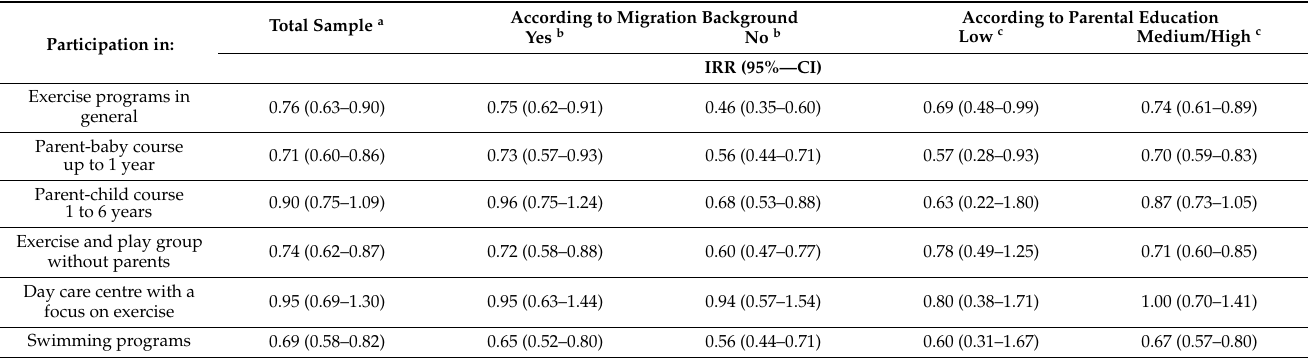
Table 3. Incidence Rate Ratios for a Finding in Body